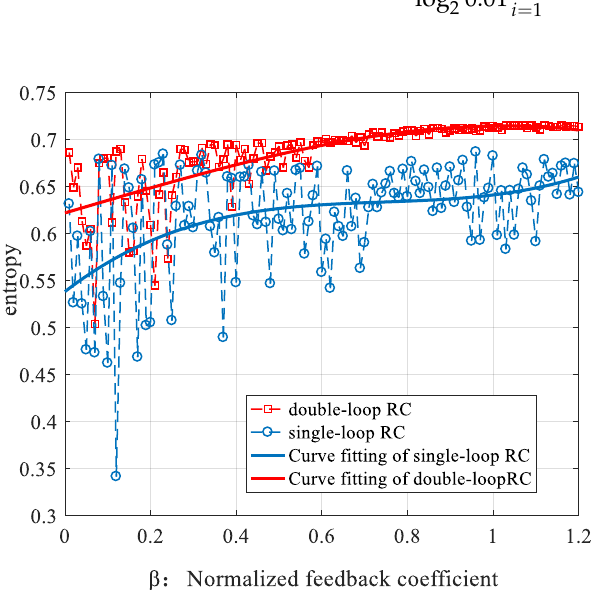
Figure 9. Entropy versus the normalized feedback coefficient.